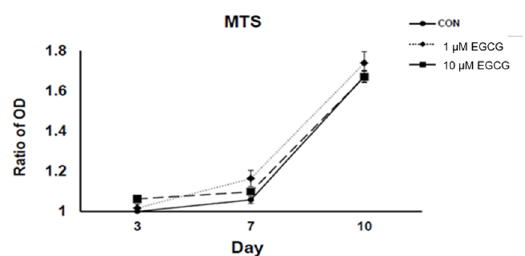
Figure 1. Effects of (−)-epigallocatechin-3-gallate (EGCG) on human bone marrow stem cells (hBMSCs) in 3-(4,5-Dimethylthiazol-2-yl)-2,5-Diphenyltetrazolium Bromide (MTS). There was no significant change in MTS assay and cell cycle after EGCG treatment at 1 and 10 µmol/L for 24 and 48 h. With treatment of EGCG, the viability of hBMSCs was not affected by EGCG at both 1 and 10 µmol/L (both p > 0.05).